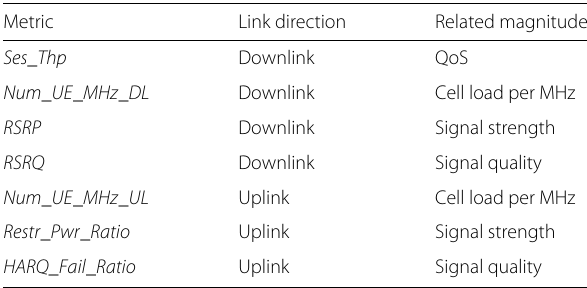
Table 2 Selected metrics from cell traces Metric Link direction Related magnitude Ses _ Thp Downlink QoS Num _ UE _ MHz _ DL Downlink Cell load per MHz RSRP Downlink Signal strength Downlink Signal quality Uplink Cell load per MHz Signal strength Uplink Signal